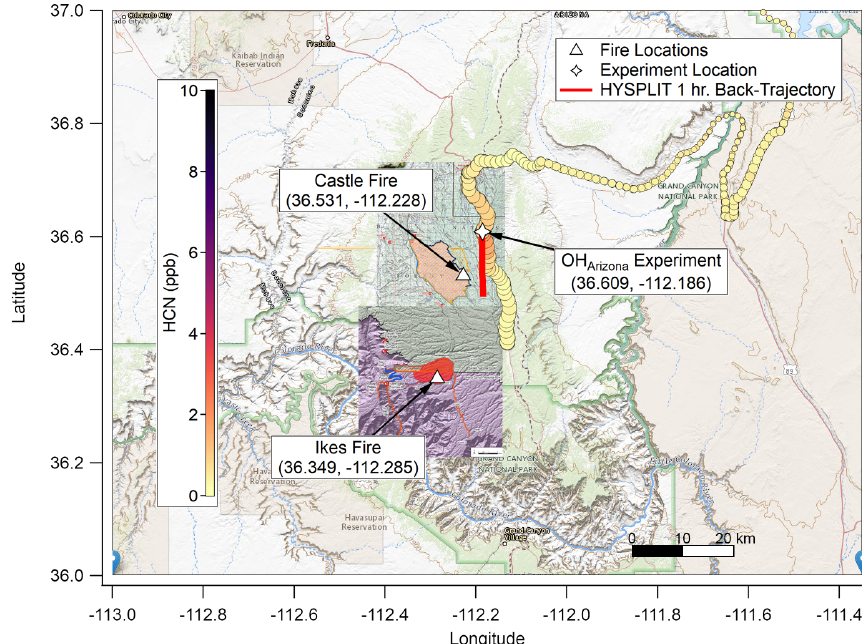
Figure 1. Map of the Grand Canyon region overlaid with hydrogen cyanide (HCN) concentration (ppb; color scale), elevation (HCN marker size; larger is higher above mean sea level (a.m.s.l.)), fire origin locations from the Incident Information System (white triangles), OH Arizona experiment location (white star), and fire boundary maps for 20 August 2019. Based on Hybrid Single-Particle Lagrangian Integrated Tra- jectory (HYSPLIT) back trajectories, the plume for this experiment was less than 1h old, though surface concentrations of smoke were comparatively lower since the nocturnal boundary layer had lifted. The background map is from USGS EarthExplorer, and fire map overlays are from the National Wildfire Coordinating Group’s Incident Information System